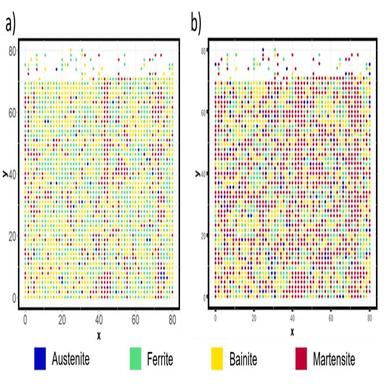
(a) Initial nanoindentation scatter plot, (b) revised nanoindentation scatter plot, validated by EBSD and supervised by the RF machine learning model. X and Y coordinates are presented in µm.